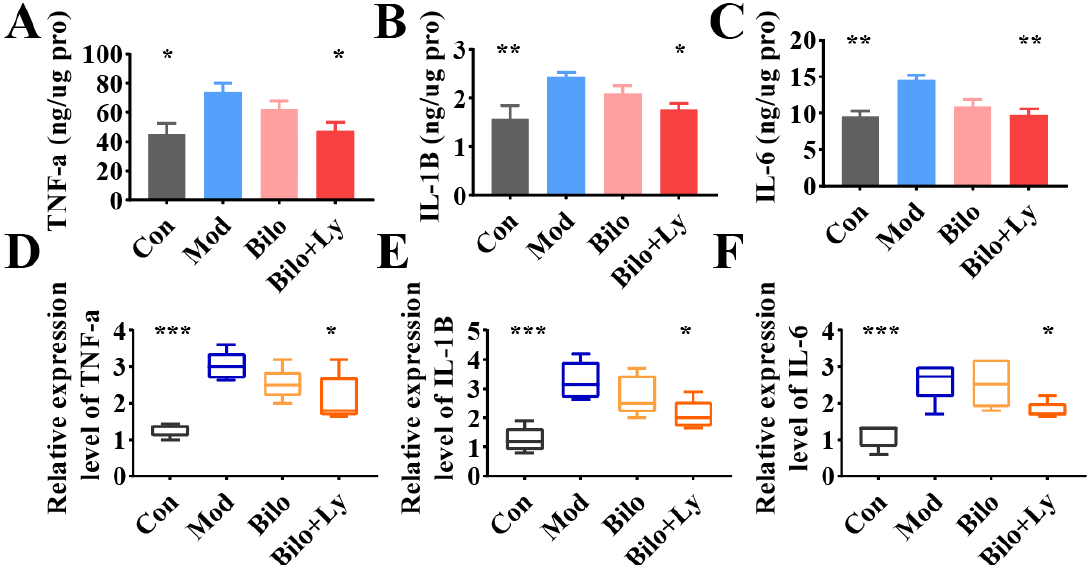
Figure 3. The effect of lycopene on the biochemical analysis of mouse kidney. The content of TNF-a in mouse kidney ( A ). The content of IL-1B in mouse kidney ( B ). The content of IL-6 in mouse kidney ( C ). Expression levels of TNF-a mRNA in mouse kidneys ( D ). The expression level of IL-1B mRNA in mouse kidney ( E ). The expression level of IL-6 mRNA in mouse kidney ( F ). Signs of significance of difference between Mod group and other groups: * p < 0.05, ** p < 0.01, *** p <